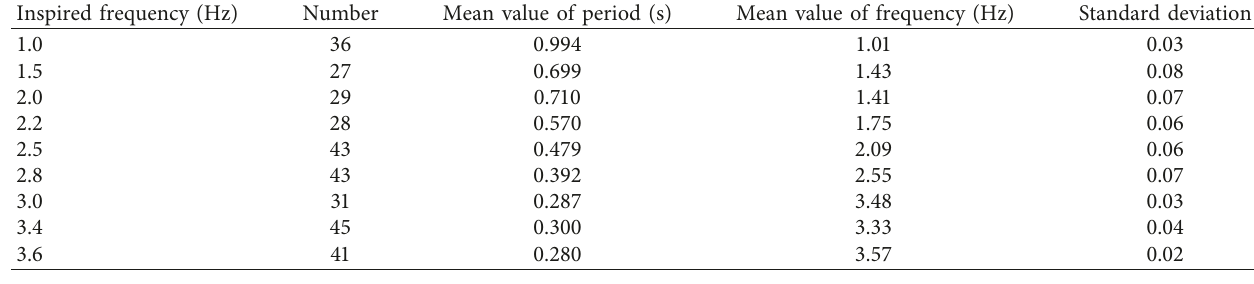
Figure 8: The test structure and test points. (a) The size of structure. (b) Acceleration and displacement point. (c) Strain point. Table 5: Comparisons of metronome frequencies and crowd response